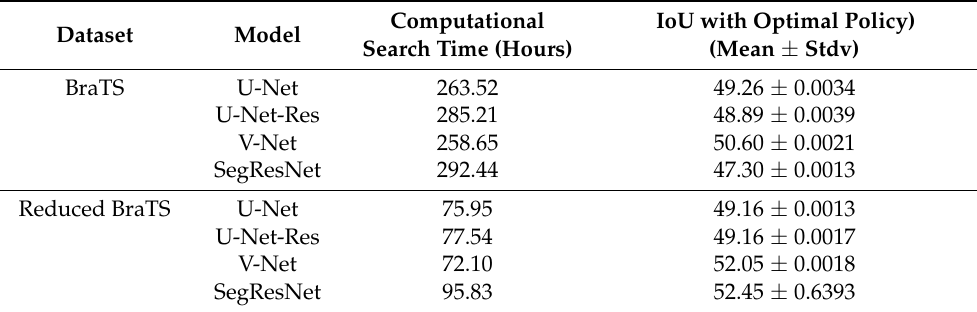
Table A5. Evaluation on performance with BraTS and reduced BraTS using our medical DA